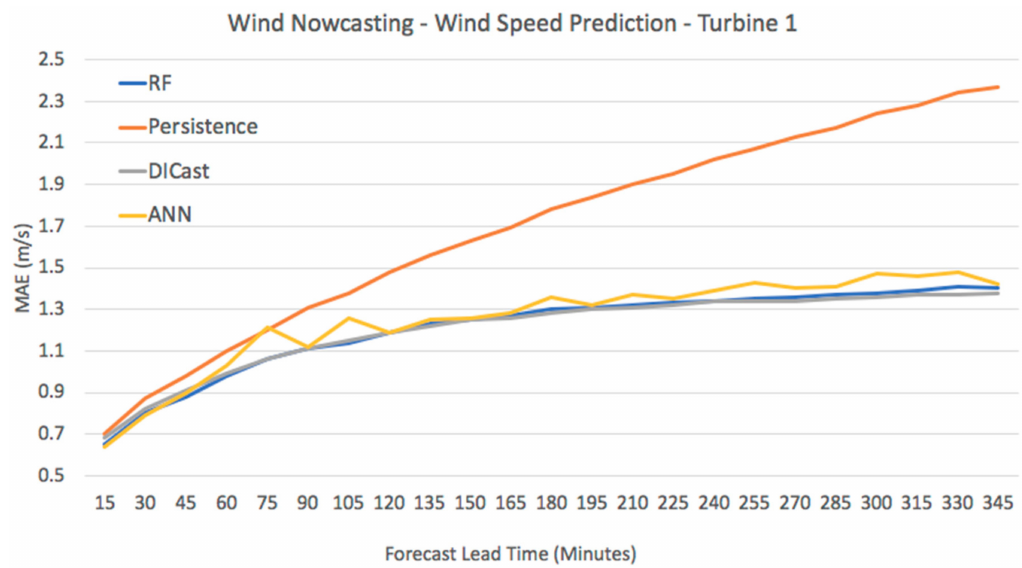
Figure 9. Results (MAE) for the random forest (blue line), ANN (gold line), persistence (orange line), and the DICast hub height wind speed forecast (gray line) that show the DICast and RF perform similarly well.